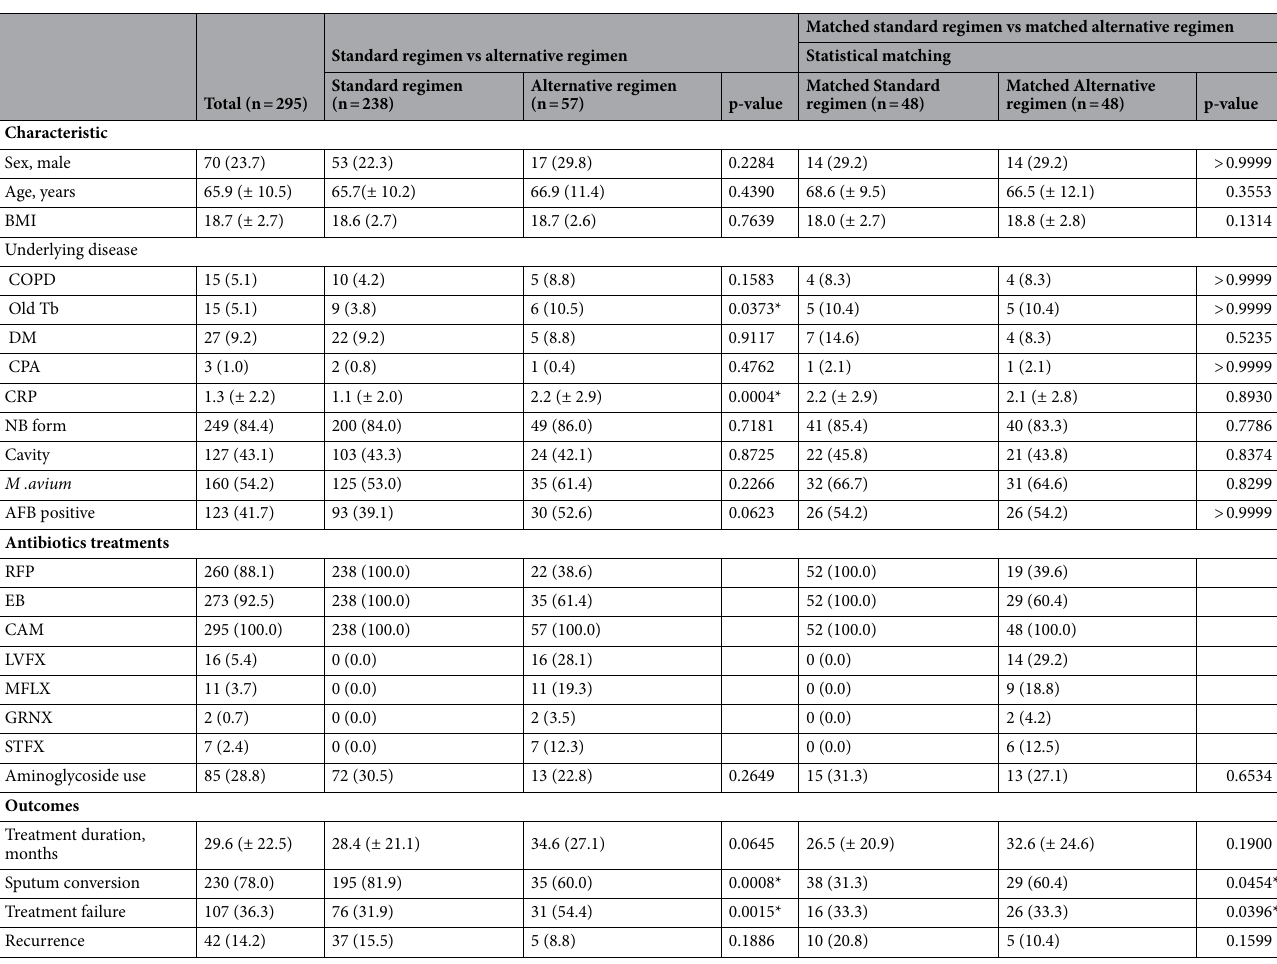
Table 1. Baseline characteristics and treatment outcomes of MAC-PD patients. Data represent n (%) or median (interquartile range). MAC-PD Mycobacterium avium complex pulmonary disease; BMI body mass index; COPD chronic obstructive pulmonary disease; Tb tuberculosis; DM diabetes mellitus; CPA chronic pulmonary aspergillosis; CRP C-reactive protein; NB nodular bronchiectasis; CAM clarithromycin; RFP rifampicin; EB ethambutol; LVFX levofloxacin; MFLX moxifloxacin; STFX sitafloxacin; GRNX